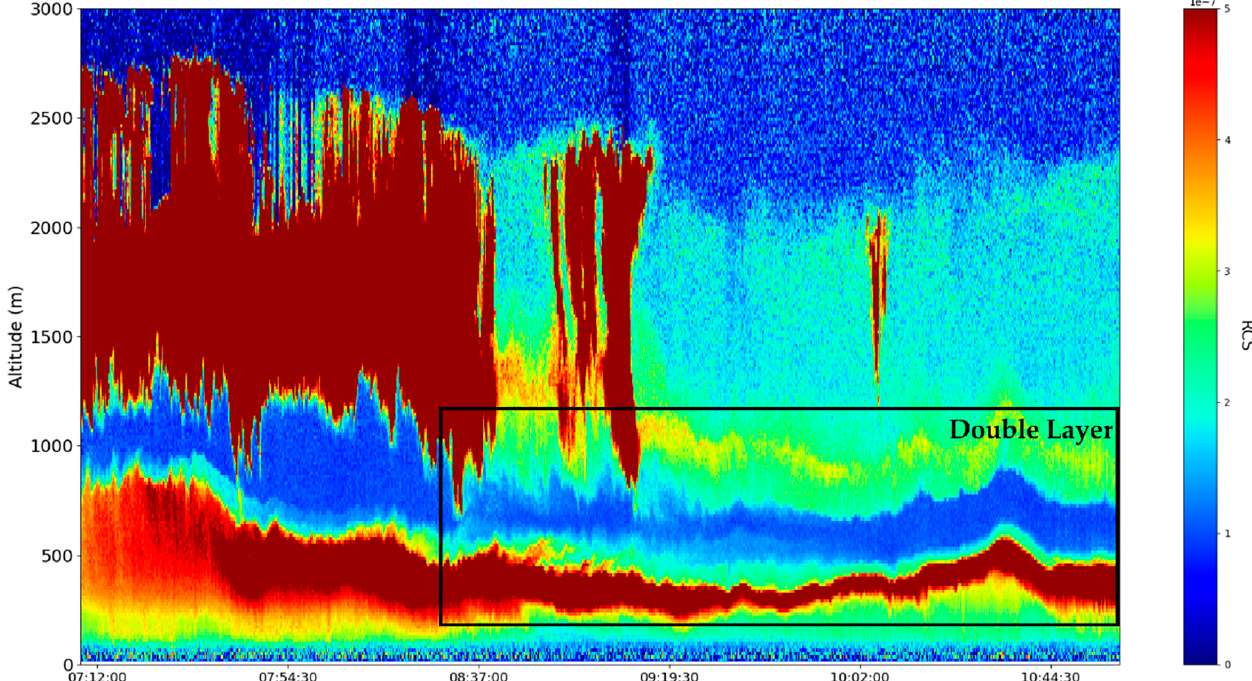
Figure 14. Zoomed-in (region of interest) RCS time series, λ = 1064 nm , Gala ț i, Romania, 23 December 2021.